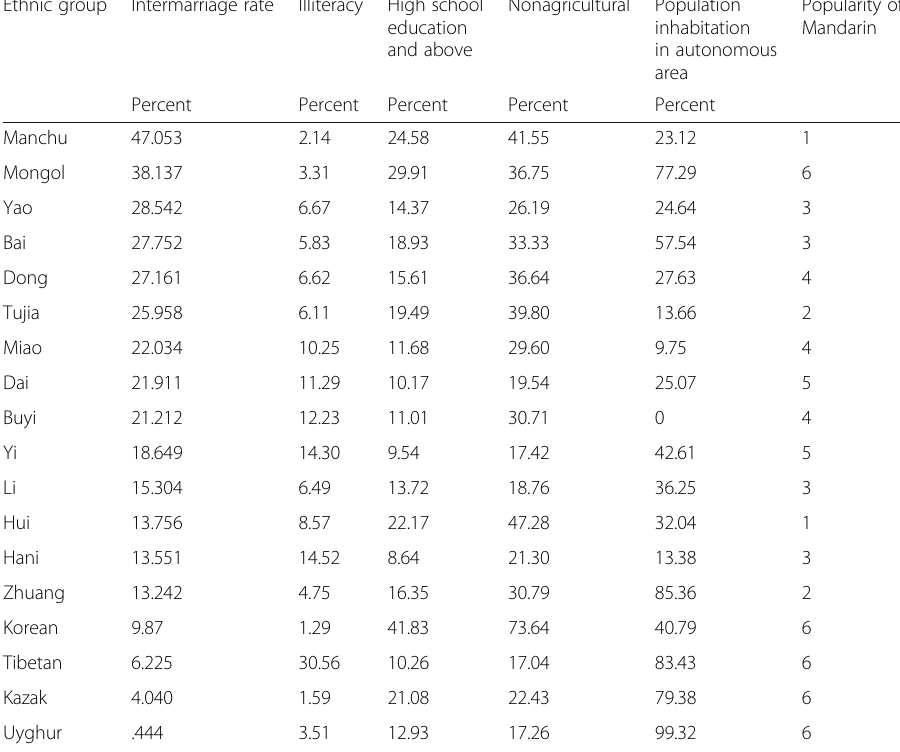
Table 6 Related data of 18 ethnic minorities in 2010 (in descending order of intermarriage rate) Ethnic group Intermarriage rate Illiteracy High school